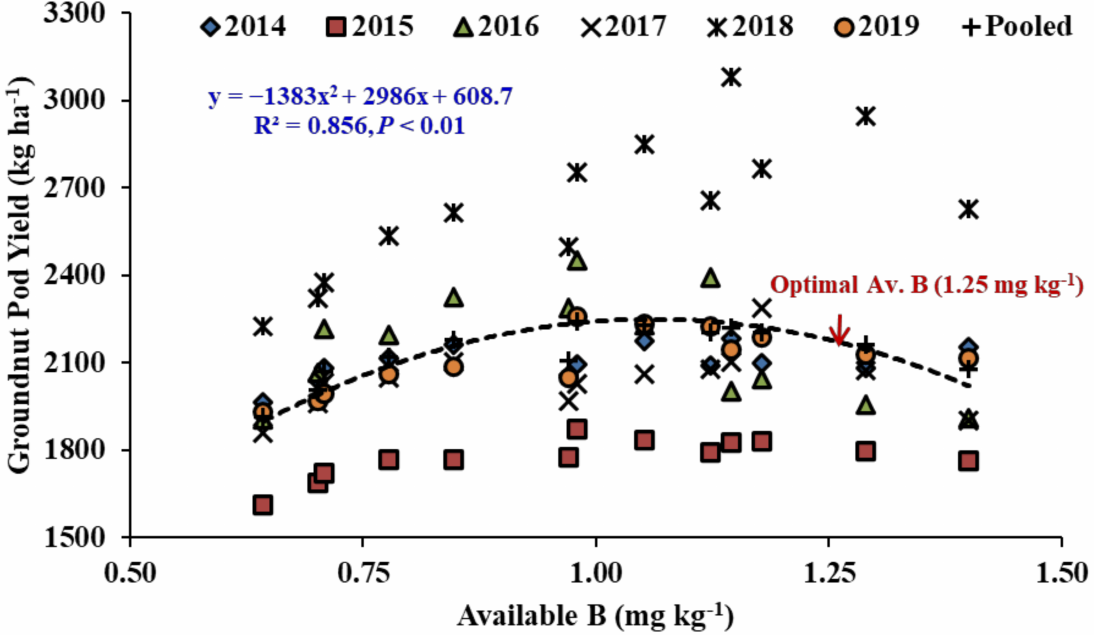
Figure 3. Response function and physical optimal available B for the highest groundnut-pod yield in relation to B fertilization to groundnut crop in groundnut-cabbage cropping